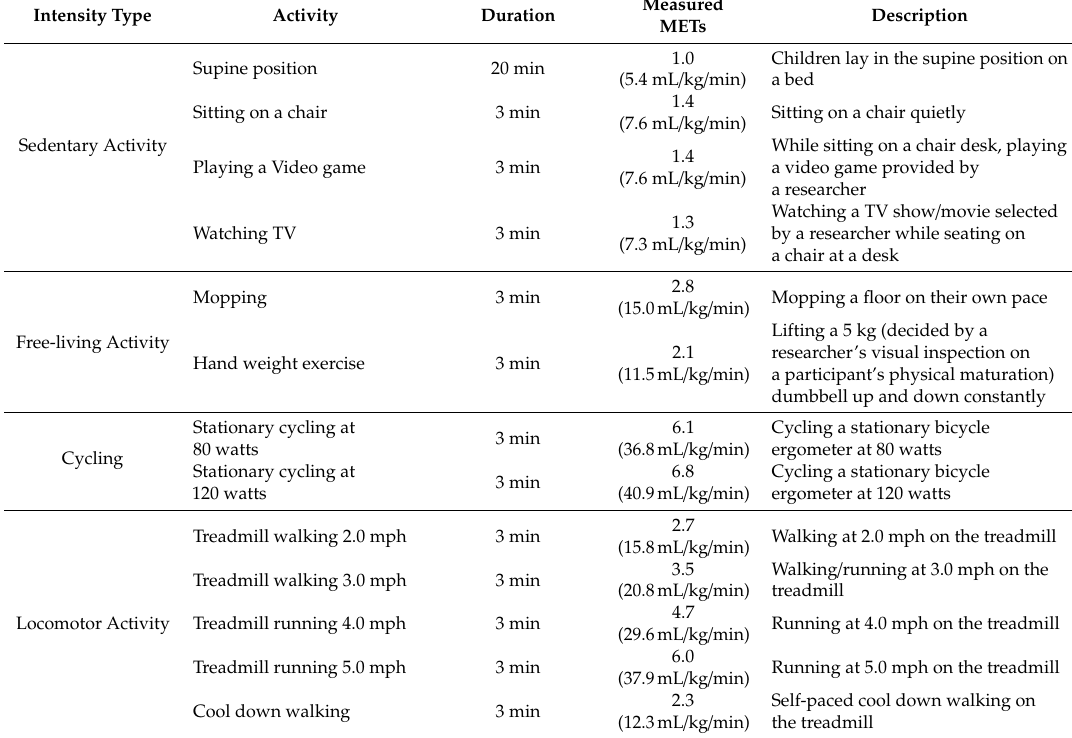
Table 1. Description of performed activities by